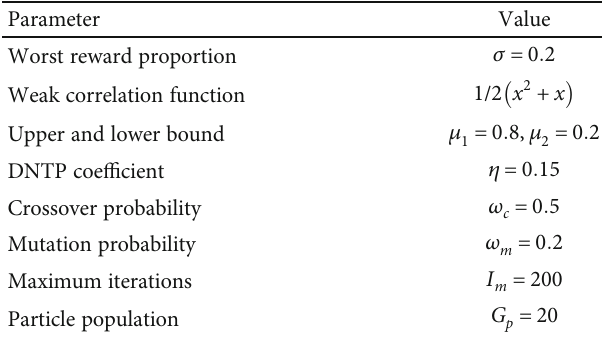
Table 3: Hyperparameter setting for